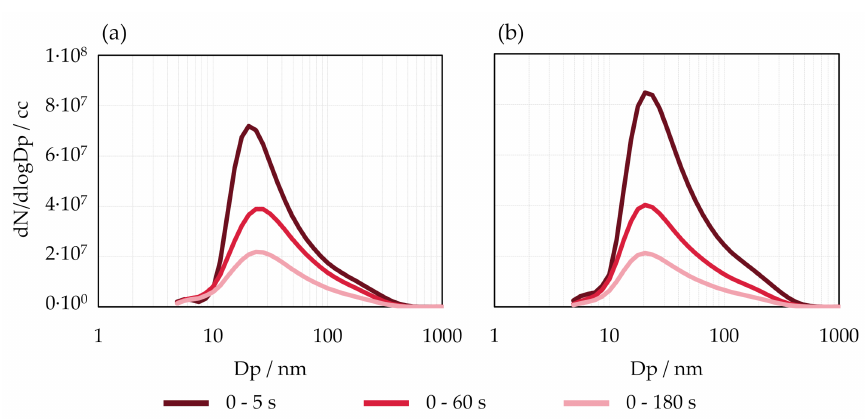
Figure 5. Size spectral density curves ( a , b ), both representing a cold start at − 15 ◦ C (dTWC sampling). The exact GMDs of the emitted particulate matter for all T Coolant = − 15 ◦ C cold start measurements performed are shown in Table 5. The average GMD of the soot